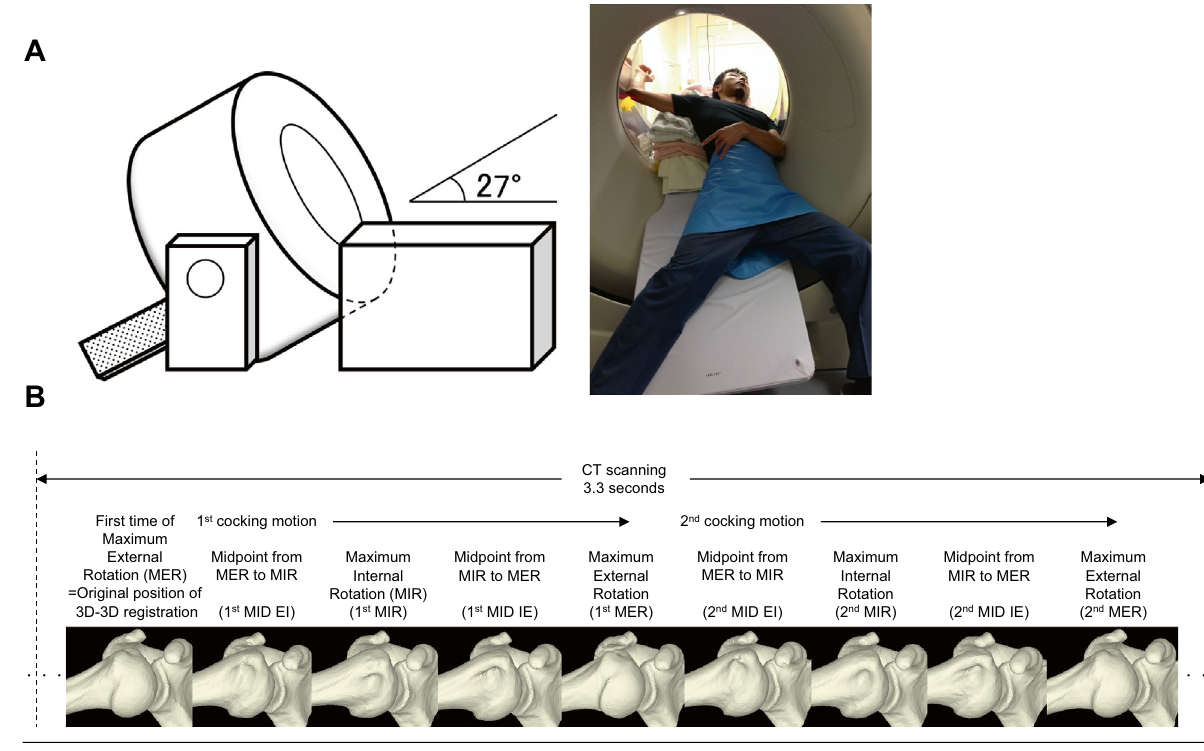
Figure 1. 4D CT scanning of the shoulder joint during simulated pitching motion and definition of each shoulder position. ( A ) 4D CT image acquisition, the maximum angle between the board and the ground was 27° and the patient rotates the shoulder in the computed tomography gantry, ( B ) definition of each shoulder position through 3.3 s scanning time of two cocking motions controlled to a rhythm of metronome. MER, maximum external rotation; MIR, maximum internal rotation; MID EI, midpoint from MER to MIR; MID IE, midpoint from MIR to